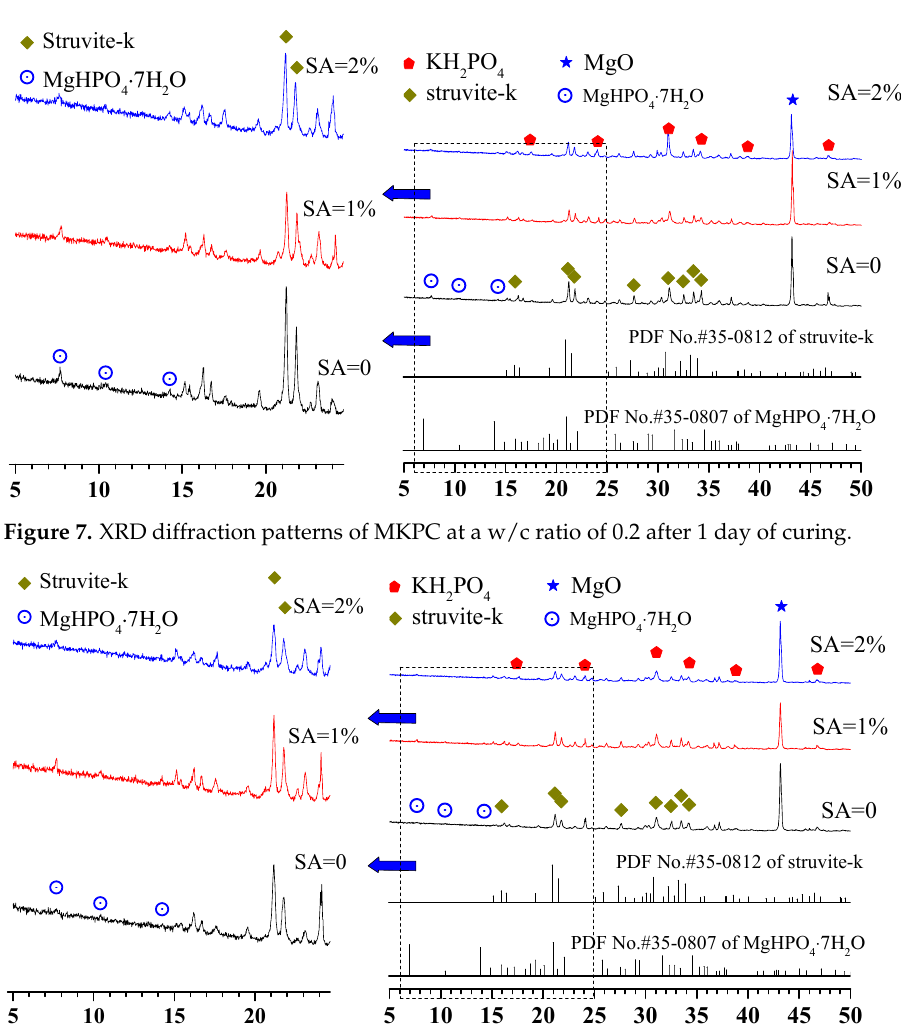
Figure 8. XRD diffraction patterns of MKPC at a w/c ratio of 0.2 after 28 days of curing. To illustrate the effect of the sodium alginate content on the hydration product of MKPCs, XRD diffraction patterns of MKPC at a w/c ratio of 0.2 are shown in Figure 9 at different stages of hydration. With the progress of hydration, the struvite-k from MKPCs with 1% sodium alginate increased with age. On the other hand, the struvite-k increased first and decreased afterward for the MKPCs with 2% sodium alginate. This suggests that adding no more than 1% of sodium alginate did not have a notably adverse effect on the formation of hydration products over the long term, but an unfavorable effect could be found when sodium alginate exceeded 1%. For the MKPCs with 2% sodium alginate, the struvite-k formed at 1 day tended to be dissolved; therefore, the quantity of struvite-k at 28 days was lower than that at 1 day. This may explain the decrease in compressive strength of the MKPCs at the later